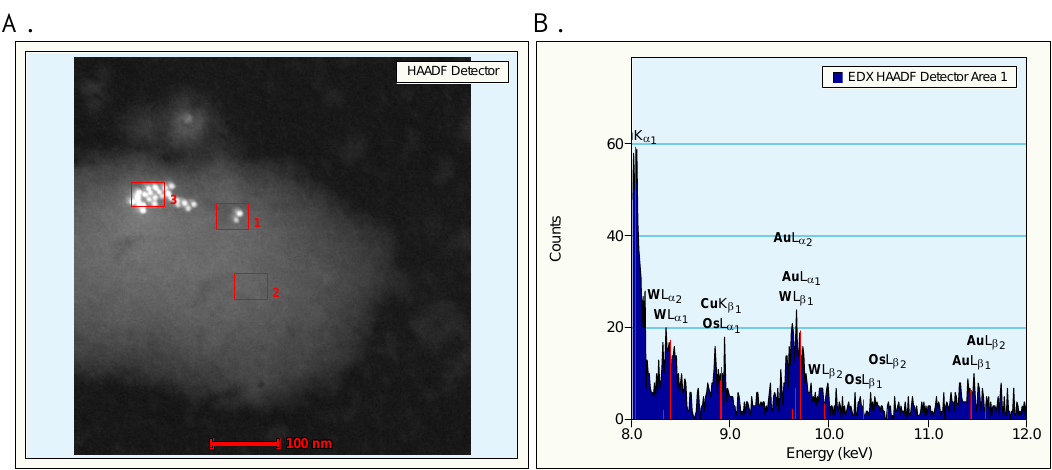
Figure 1. EDX spectrum analysis of 10 nm gold suspension. A. The red squares highlight evaluated areas 1–3; B. Area 1 shows the presence of two nanoparticles, which at EDX spectrum analysis contained gold; C. Area 2 as negative control area contained only wolfram (W); D. Area 3 shows an agglomerate of particles identified to contain gold. A.